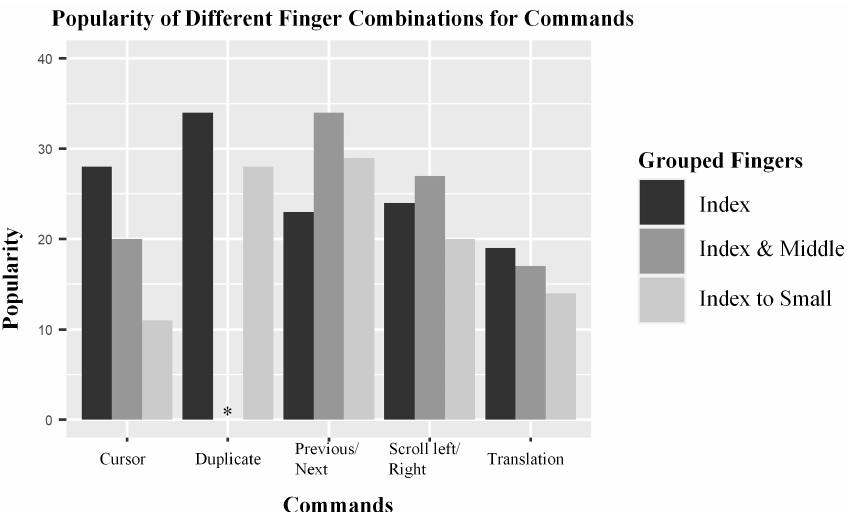
Figure 8. The number of participants (popularity) who assigned gestures with different finger combina- tions to five commands, * indicating that such finger combination was not available for this